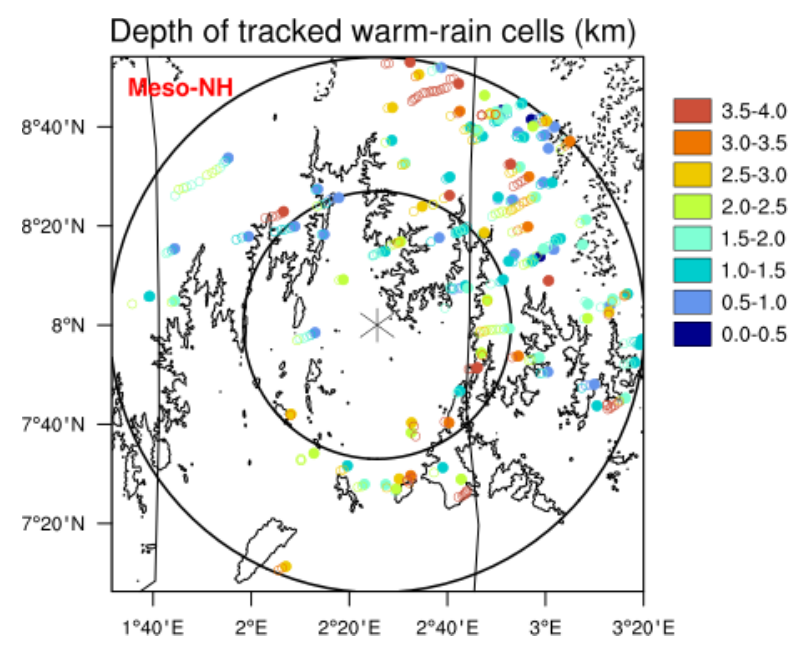
Figure 10. As in Figure 9 (only for the simulation), but colors represent the depth of the tracked warm-rain